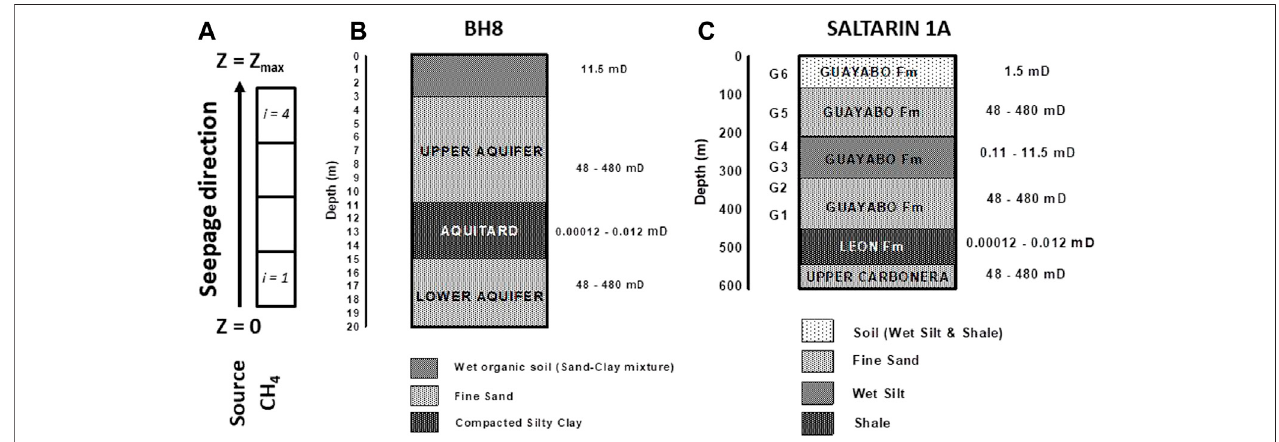
FIGURE 4 | (A) Border conditions and parameters used for the numerical modeling (superposition principle). The continuous gas source for BH8 was set at 20 m coinciding with a low resistivity anomaly in the southern end of the land fi ll (Jacome et al., 2021). In Saltarin 1A the methane source was placed in the upper unit of the reservoir Carbonera Formation (608.2 m). The fi gure also shows the arrangements of sedimentary layers, with their possible permeability ranges, used to model the fractionofmethane concentrationswithdepthfor: (B) BoreholeBH8basedonthehydrostratigraphicdescription byJacomeetal.(2021) of Figure1B . (C) Oilwell Saltarin 1A based on the lithological description by Bayona et al. (2008) of Figure 2B .